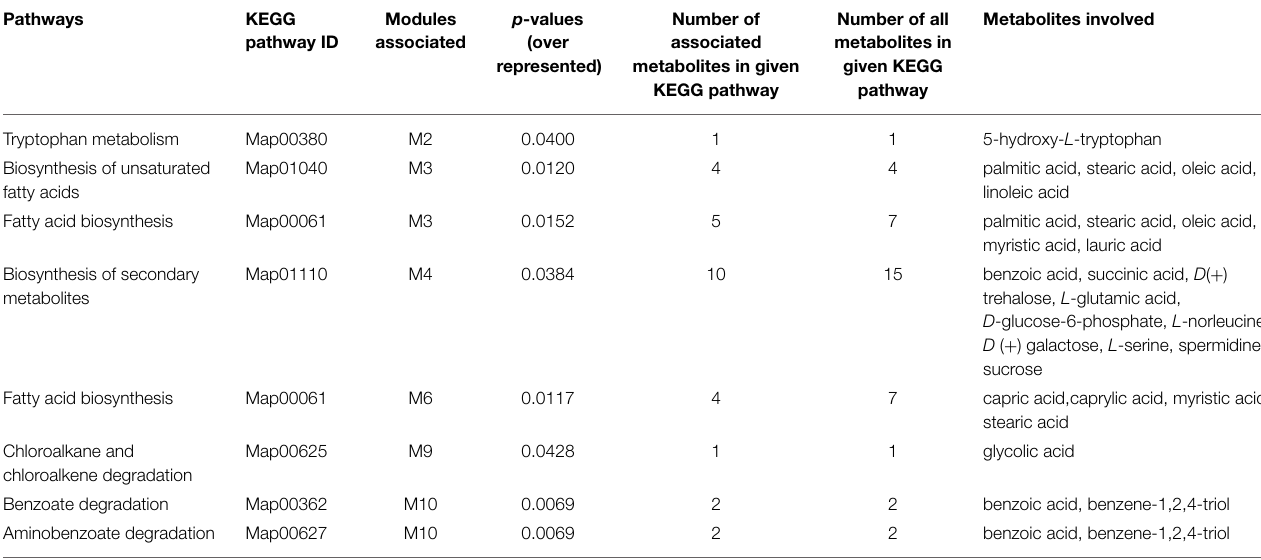
TABLE 3 | Pathway enrichment analysis of metabolites associated with the ethanol stress condition * .